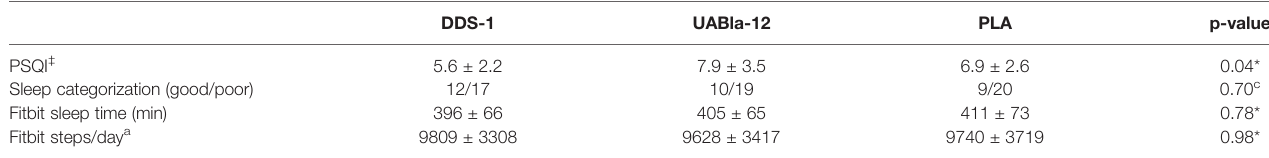
TABLE 2 | Differences between the groups at V1 in sleep quality based on the PSQI and in sleep minutes and steps as measured by fi tbit.